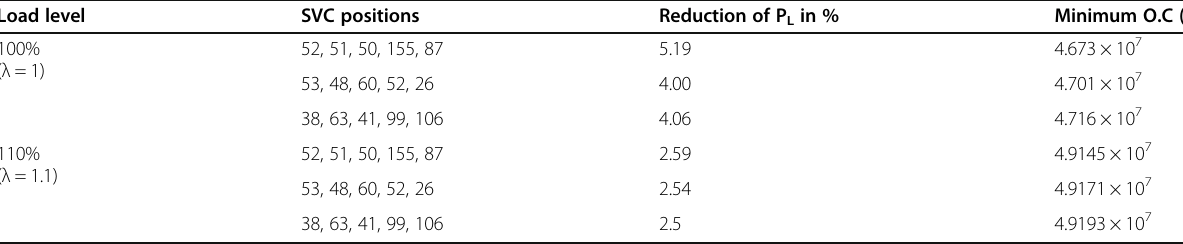
Table 15 Comparison between SVC allocation and effects on System